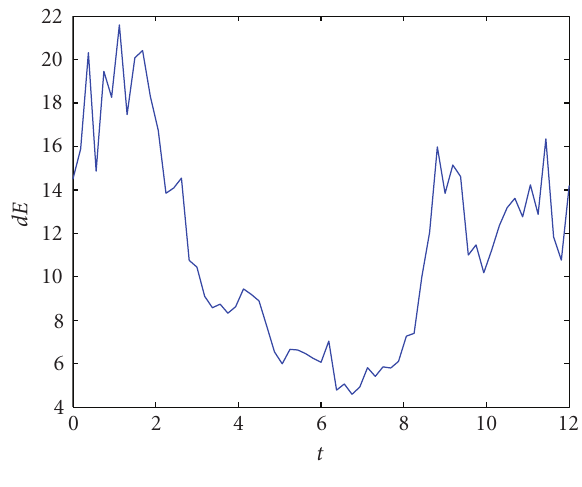
Figure 4.2. Trajectories of simulated